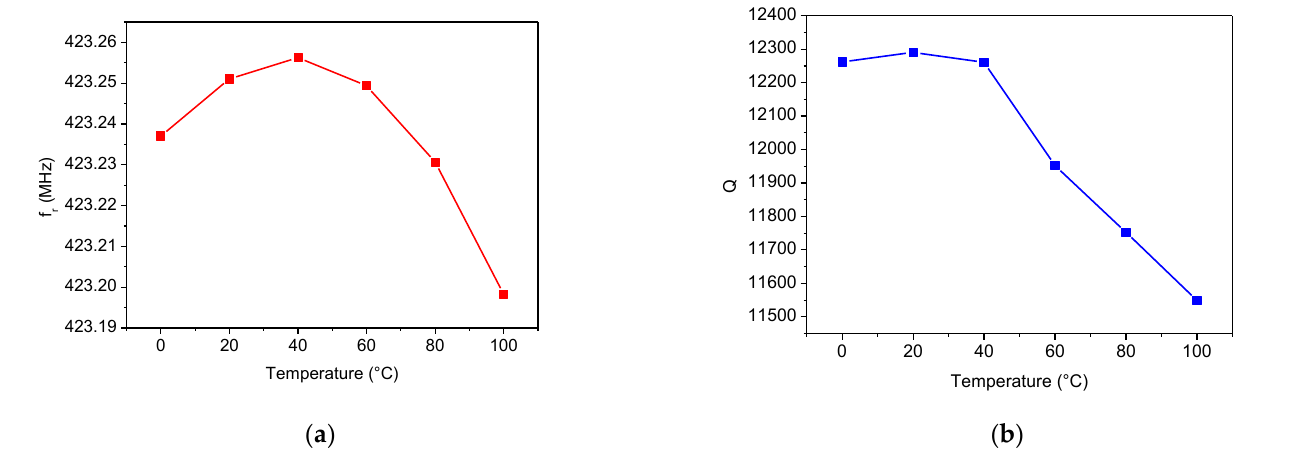
Figure 14. Temperature dependence of the input and output shunt static capacitances. The temperature dependence of the three lumped elements, R m , L m , and C m , is de- picted in Figure 13. When the temperature increases, both the inductance and resistance values increase while the capacitance C m decreases. It is worth noting how the resistance value is related to the resonator Q factor. As described in Section 2.2, from a physical point of view, the resistance R m represents the damping effect. In other words, it is related to the resonator losses. As the temperature increases, the series resistance R m increases, thus low- ering the resonator Q factor (see Figures 12a and 13c). Finally, the variation in the two input/output shunt static capacitances with the tem- perature is reported in Figure 14. In general, the extracted values of C 01 are very close to those of C 02 . Except for an abrupt change in the values of the two capacitances when de- creasing the temperature from 20 °C to 0 °C, C 01 and C 02 are almost constant and equal to 2.00 pF and 2.13 pF, respectively. Such behavior was not observed in [34], where a similar SAW was characterized using a cryogenic experimental system. In this case, the abrupt change of C 01 and C 02 at 0 °C may be ascribed to water vapor condensation on the SAW package affecting the equivalent parasitic capacitances of the case. 4. Conclusions In the present article, a SAW resonator was characterized in terms of Y- parameters in the temperature range from 0 °C to 100 °C. A lumped-element equivalent circuit was employed to model the device under test over the investigated temperature range. Each element of the equivalent-circuit model was extracted from the measurement carried out on the physical device and circuit simulations were performed in order to evaluate the